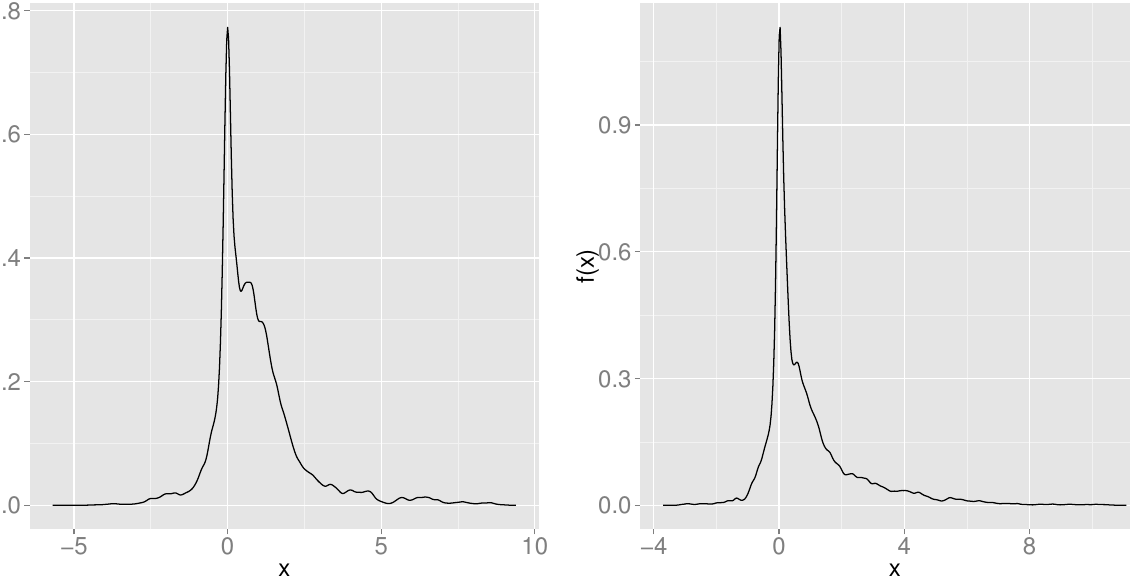
| measures the difference in absolute | − | H MT = | H SV Figure 3. The random variable τ y y y out-of-sample hedging error between two models, Heston’s model and the overconstrained L 2 Markov Tree (MT) model, for one day in year y . Here we show kernel density estimates of the probability density function for τ for years y = 2009 ( left ) and y = 2010 ( right ). y ≥ Positive outcomes of τ indicate the superiority of the MT model. Note that P ( τ y 2009 0) ≈ 0 . 76 and P ( τ ≥ 0) ≈ 0 . 79 ; the mean values of τ and τ are 0 . 8707 and 2010 2009 2010 0 . 9089 ,